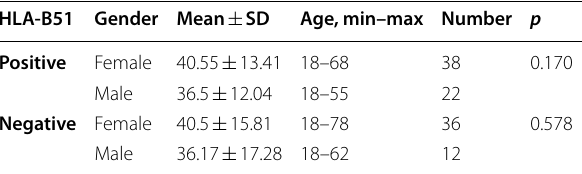
Table 2 Gender distribution and mean age of the Behçet